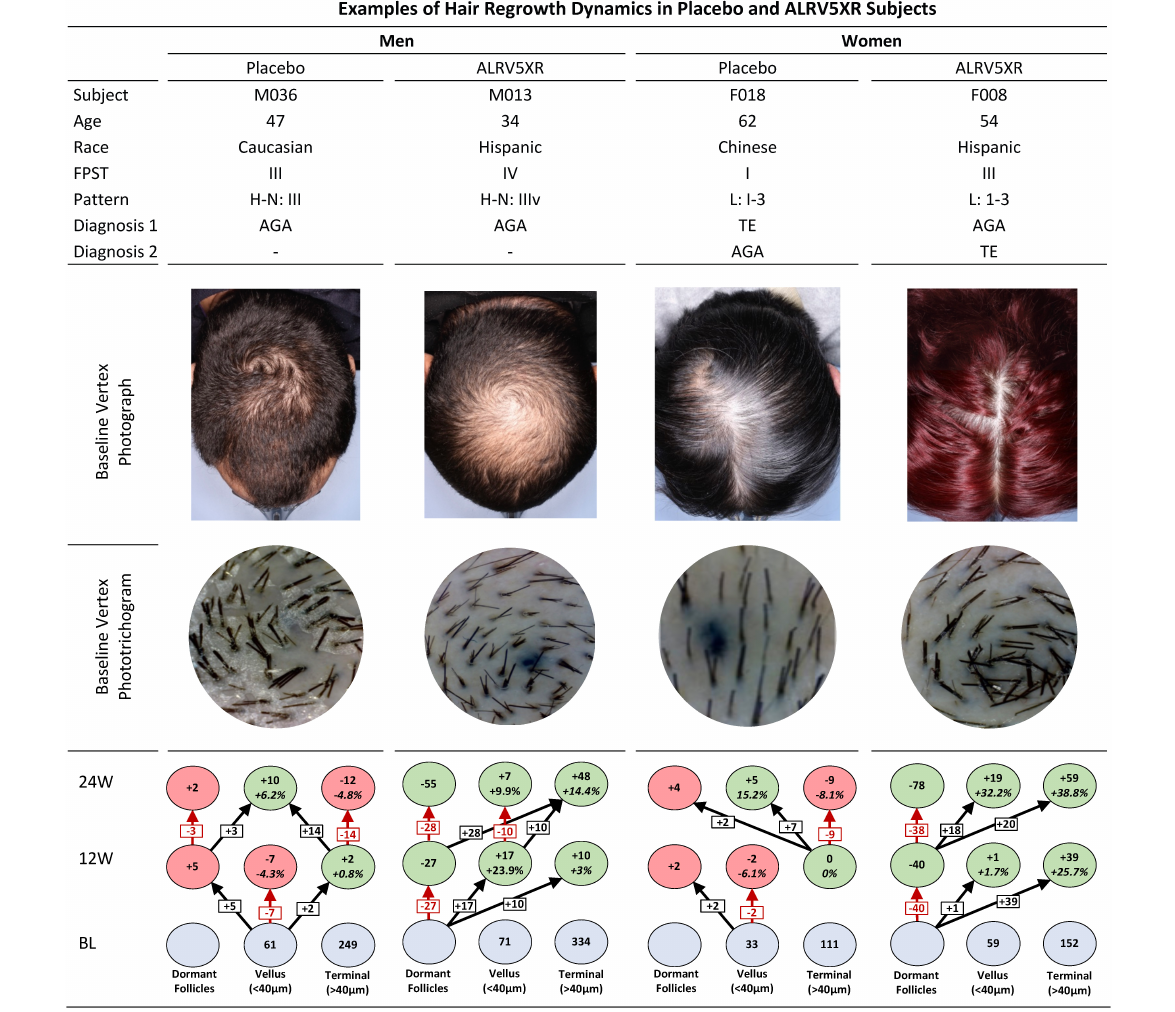
Figure 2A . This same effect is seen in the ALRV5XR group, where arrows mostly point to the right in Figure 2C , but net hair shifts are < 10 Hairs/cm 2 . In the placebo group, regrowth dynamics are very different, as seen in Figure 2E , with